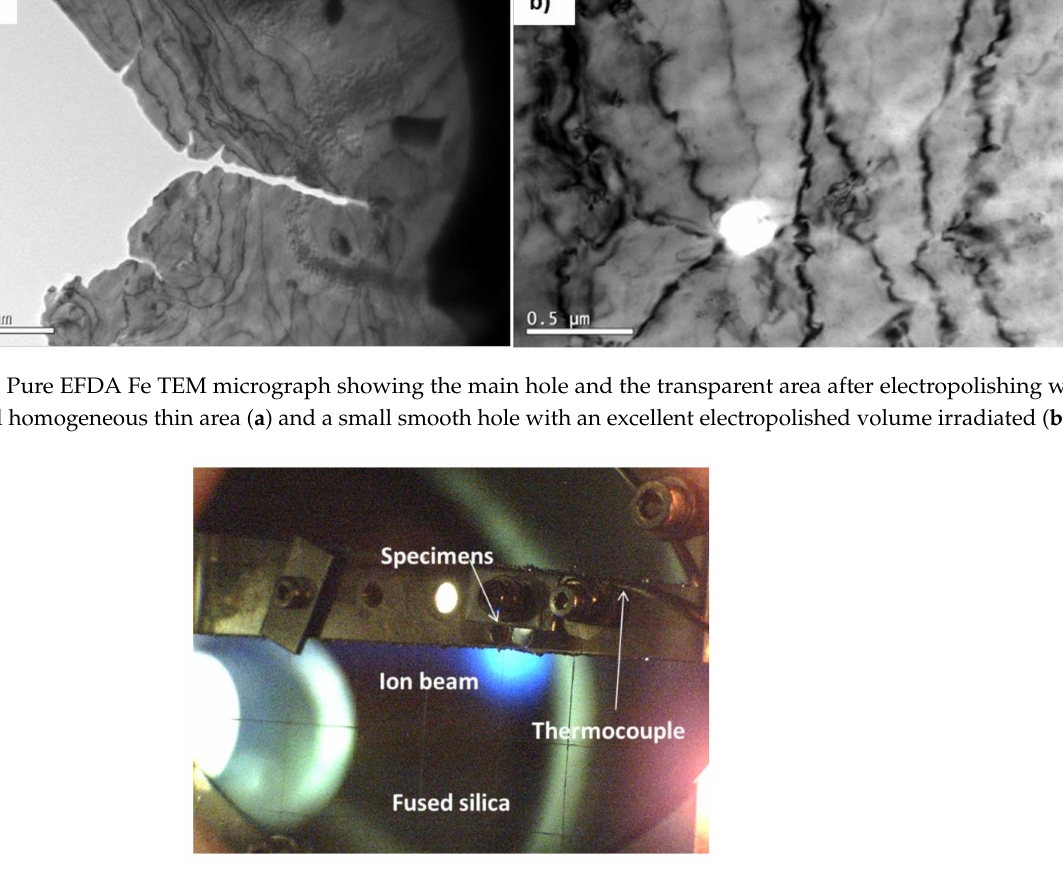
Figure 2. Sample holder shows the irradiated discs, with part of the beam hitting the fused silica (blue light). The image was taken with a considerable integration time to enhance